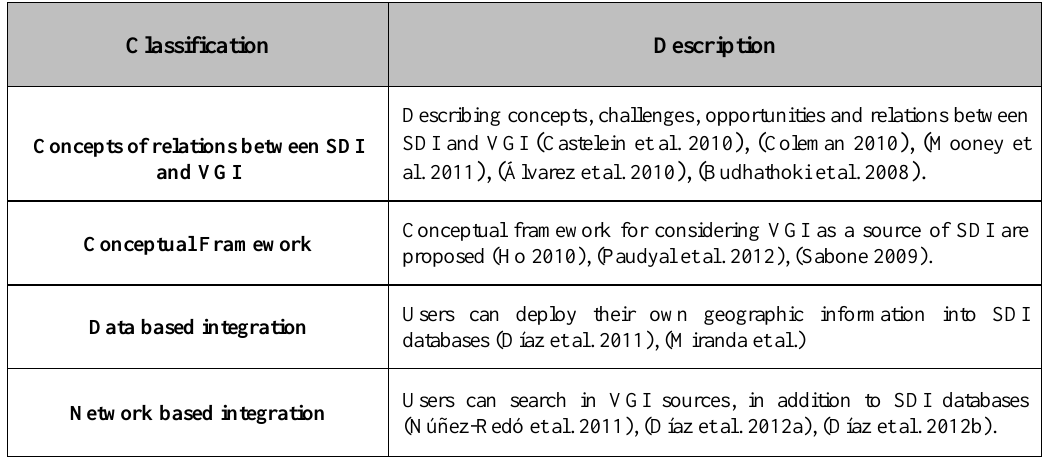
Table 1. Classification of past works on VGI and SDI